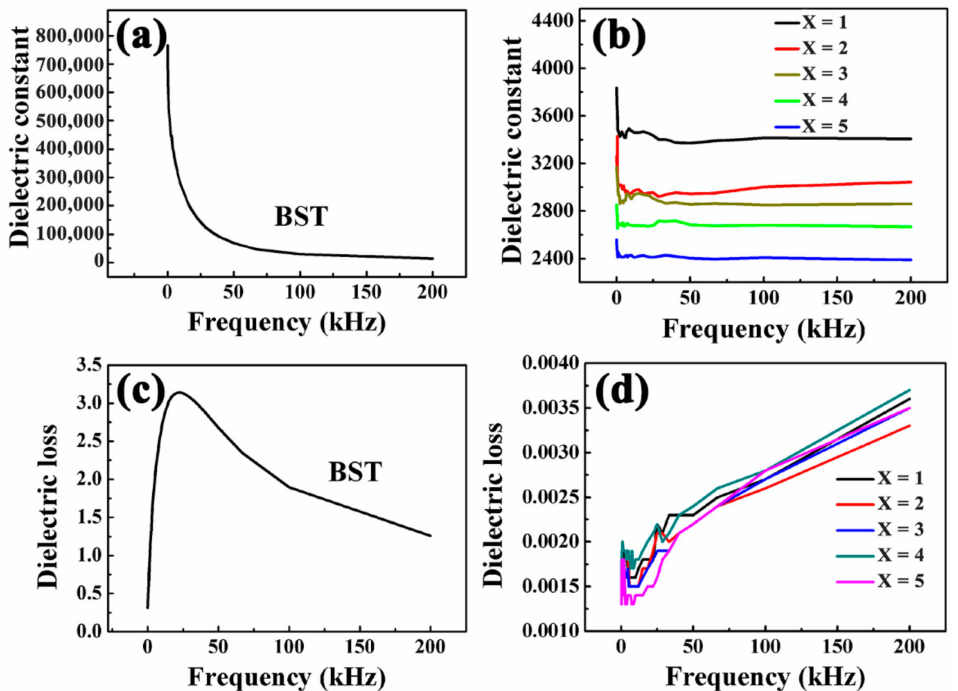
Figure 8. Dielectric constant-frequency curves of the ( a ) BST and ( b ) BST- x mol% MgO ( x = 1, 2, 3, 4, 5) ceramics. Dielectric loss-frequency curves of the ( c ) BST and ( d ) BST- x mol% MgO ( x = 1, 2, 3, 4, 5)